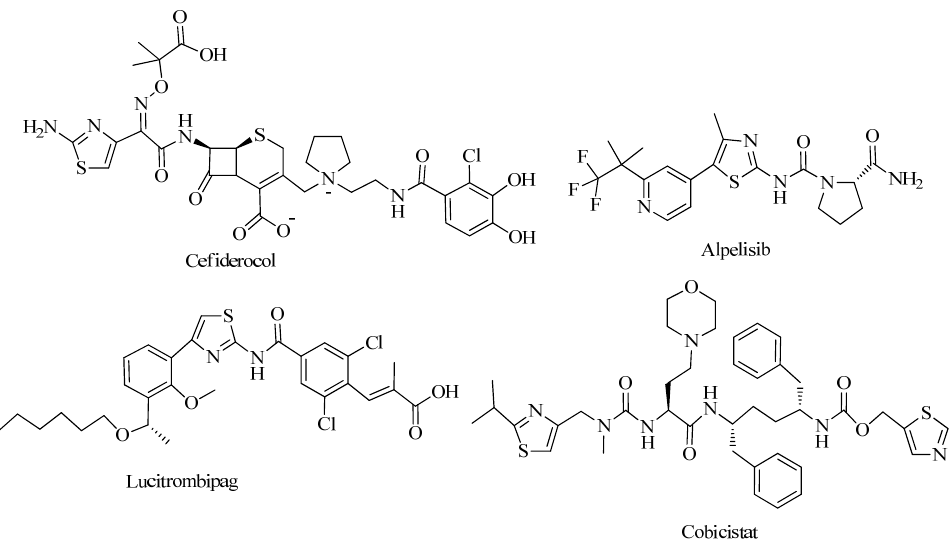
Figure 1. Structures of thiazole-bearing drugs recently approved by the FDA.